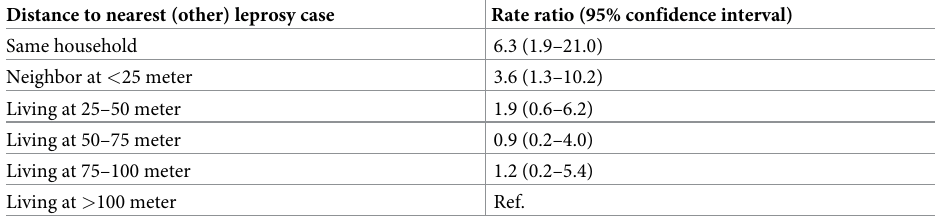
Table 2. Probability of being diagnosed with leprosy as a function of distance to the nearest index case (controlled for village of residence). Distance to nearest (other) leprosy